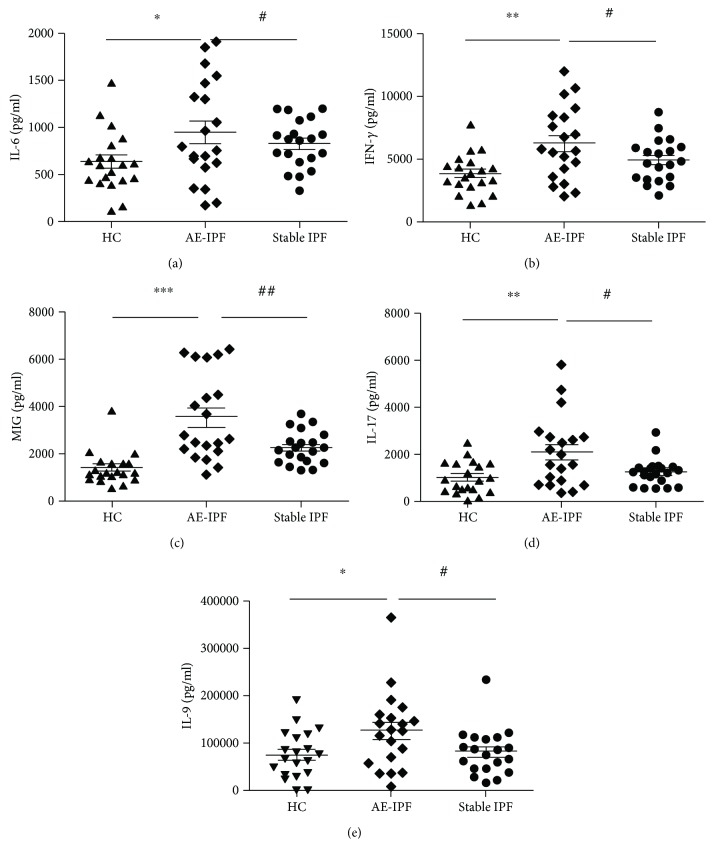
Antimicrobial inflammatory cytokines in AE-IPF. Serum of 40 IPF patients (20 AE-IPF and 20 stable IPF) and 20 controls was examined with protein microarray analysis. When compared with controls and stable IPF patients, AE-IPF patients showed significant increases in the levels of IL-6, IFN-γ, MIG, IL-17, and IL-9. One-way ANOVA followed by Tukey's post hoc test was used to compare three groups. ∗p < 0.05, ∗∗p < 0.01, ∗∗∗p < 0.001 AE IPF vs. controls. #p < 0.05, ##p < 0.01, ###p < 0.001 AE IPF vs. stable IPF.